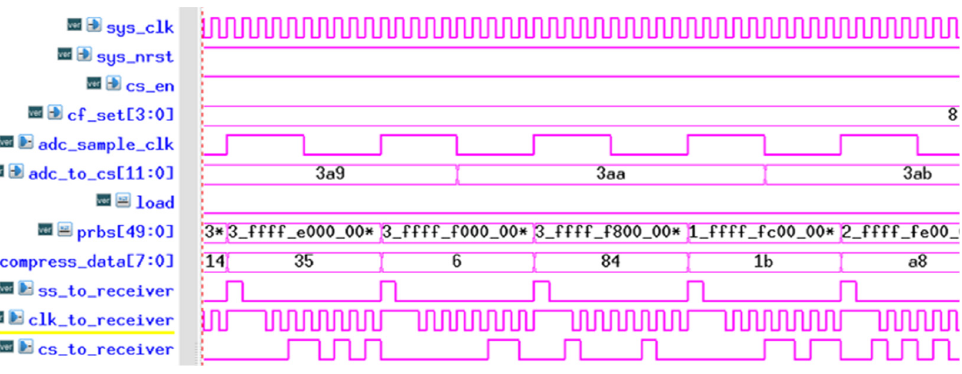
Figure 10. The Monte-Carlo simulation of the SAR ADC.